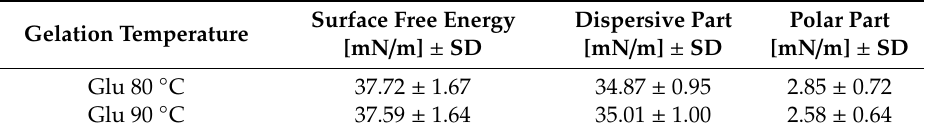
Table 4. Surface free energy and its dispersive and polar components calculated for glucan matrices gelled at di ff erent